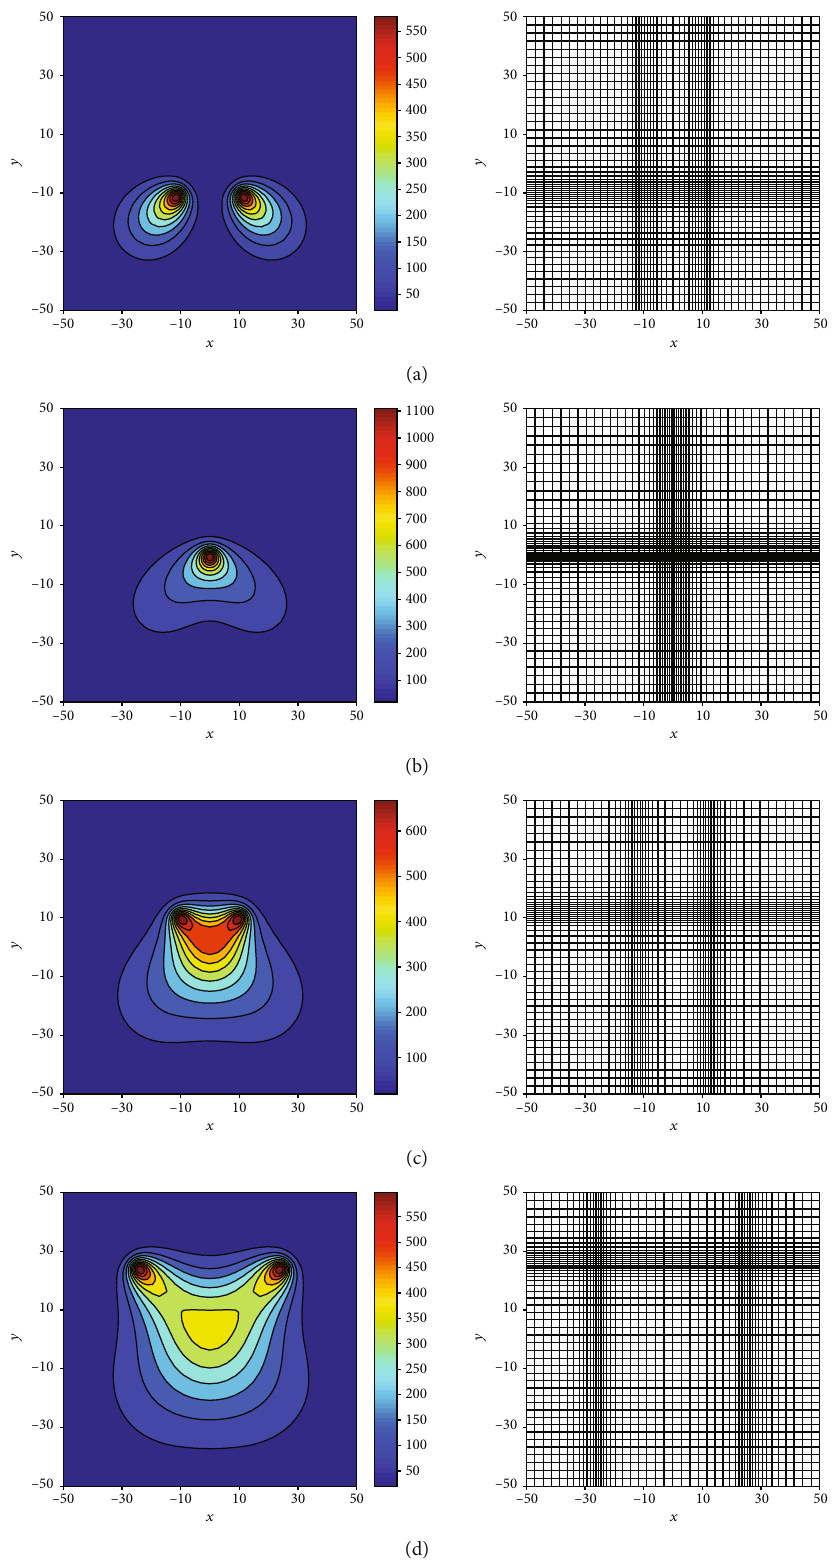
Figure 8: The transient temperature fi eld and the corresponding moving mesh at t = 10 (a), 17 : 678 , 25 , and 35 (d), respectively, for two heat sources moving along the straight lines y = ± x